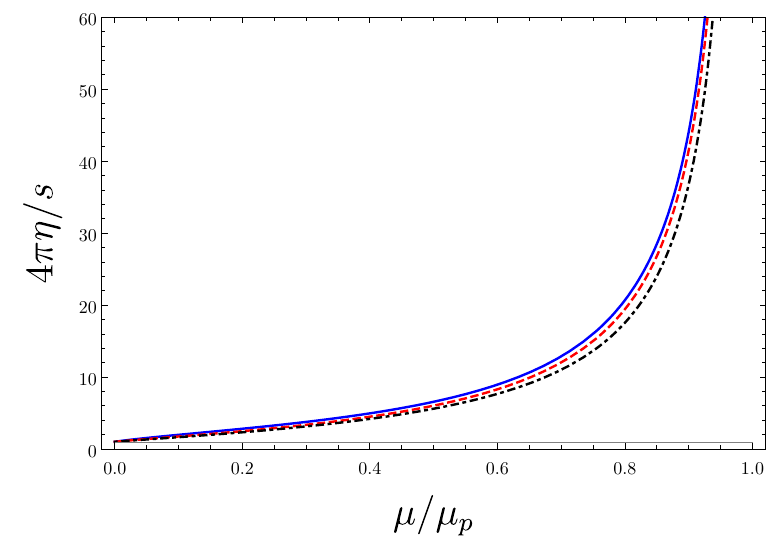
Figure 23 . Ratio of shear viscosity to entropy density : plots of the ratio (cid:17)=s in four (blue, solid), (cid:12)ve (red, dashed) and six (black, dot-dashed) dimensions. In all cases, the thin grey line represents the universal Einstein gravity value of (cid:17)=s = 1 = (4 (cid:25) ). In all cases, a [7 j 7] order Pad(cid:19)e approximant was used for a (see appendix 2